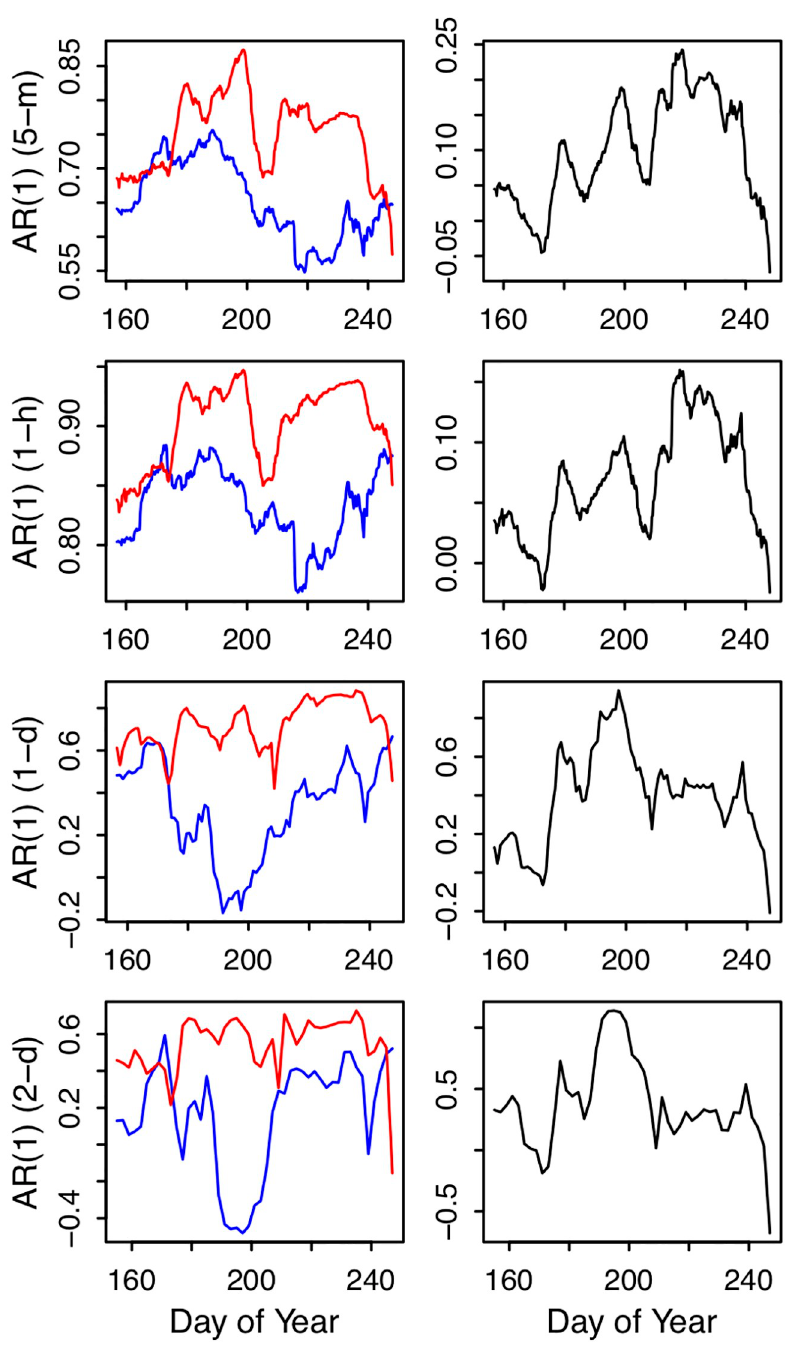
Fig 5. Rolling windows of first-order autocorrelation from detrended chlorophyll time series. Blue lines are from Paul Lake (reference), red lines are Peter Lake (manipulated). In the second column, the black lines represent the difference (Peter—Paul) between the lines in the first column (positive values indicate that autocorrelation was higher in Peter than in Paul). Time series in each row were aggregated to a different time scale prior to analysis (indicated in the y-axis label: 5-minute, 1-hour, 1-day, 2-day).